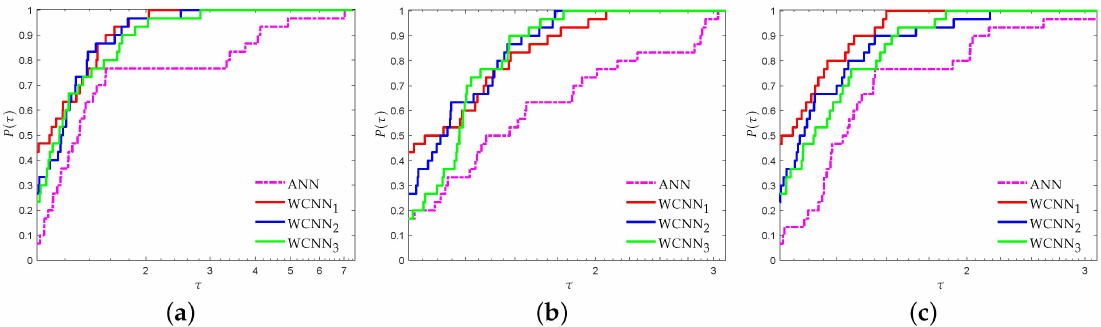
Figure 4. Performance profiles based on RMSE for domestic tourists arrivals (log 10 scaled). ( a ) Forecasting horizon = 6; ( b ) Forecasting horizon = 9; ( c ) Forecasting horizon = 12.